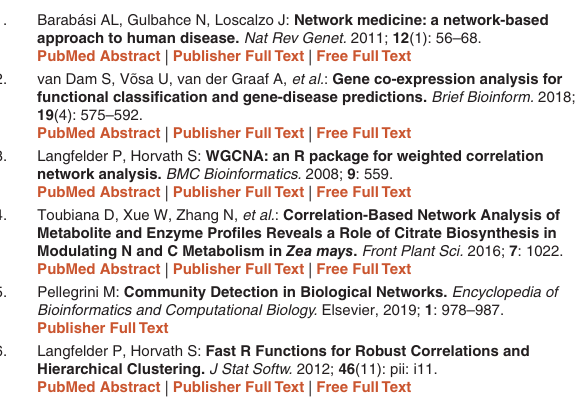
• Figure S1: The relationship between network reduction by significance of correlation or by scale-freeness • Figure S2: The weighted SBM seems not appropriate for edge prediction from edge confidence scores for fully con- nected networks • Figure S3: Pathway characteristics for alternative distance measure, and block size distributions • Figure S4: Edge predictions for a reduced weighted network with planar or hierarchical weighted